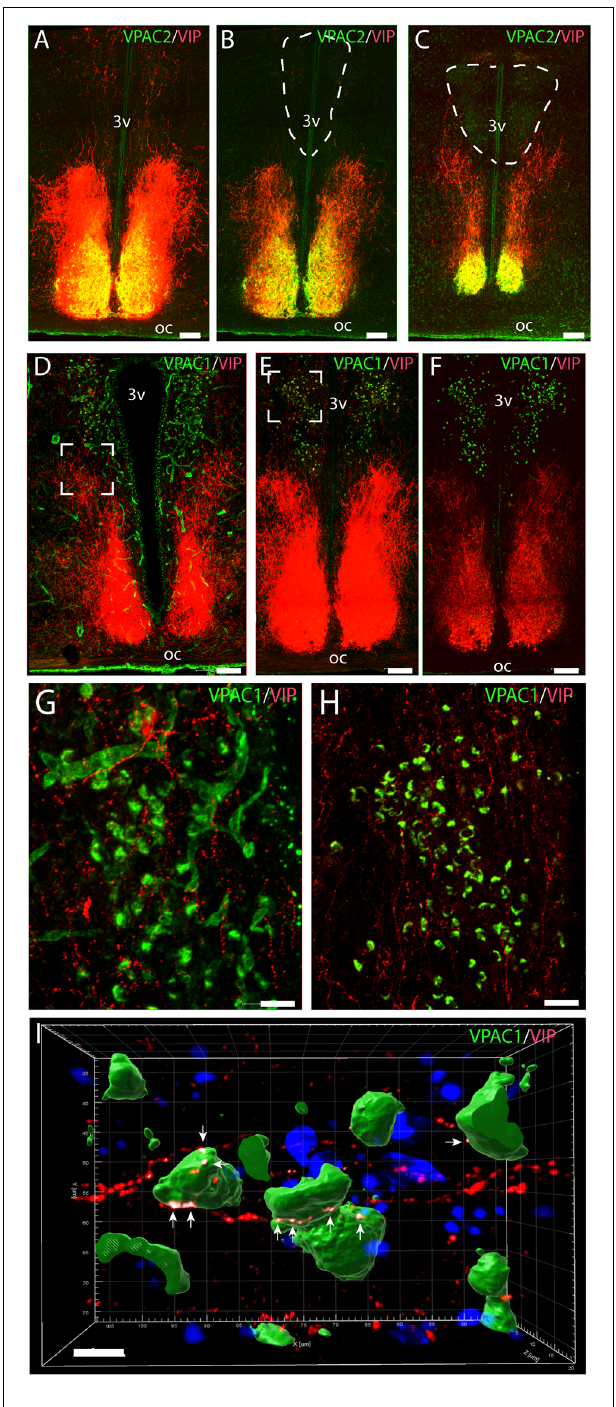
FIGURE 1 | Distribution of VPAC2 (green) and vasoactive intestinal polypeptide (VIP; red) immunoreactivity (A–C) and distribution of VPAC1 (green) and VIP (red) immunoreactivity (D–F) in the mid and rostral part of the suprachiasmatic nucleus (SCN) and paraventricular nucleus (PVN) in a wild-type mouse. Images (A–E,G,H) represent maximal projections of 14 digital sections in a Z -stack ( Z = 2 µ m). Image I represents a 3D reconstruction of a Z -stack ( Z = 0.2 µ m) of 100 images. Strong VIP and VPAC2 immunoreactivity were found in SCN (A) with VIP fibers